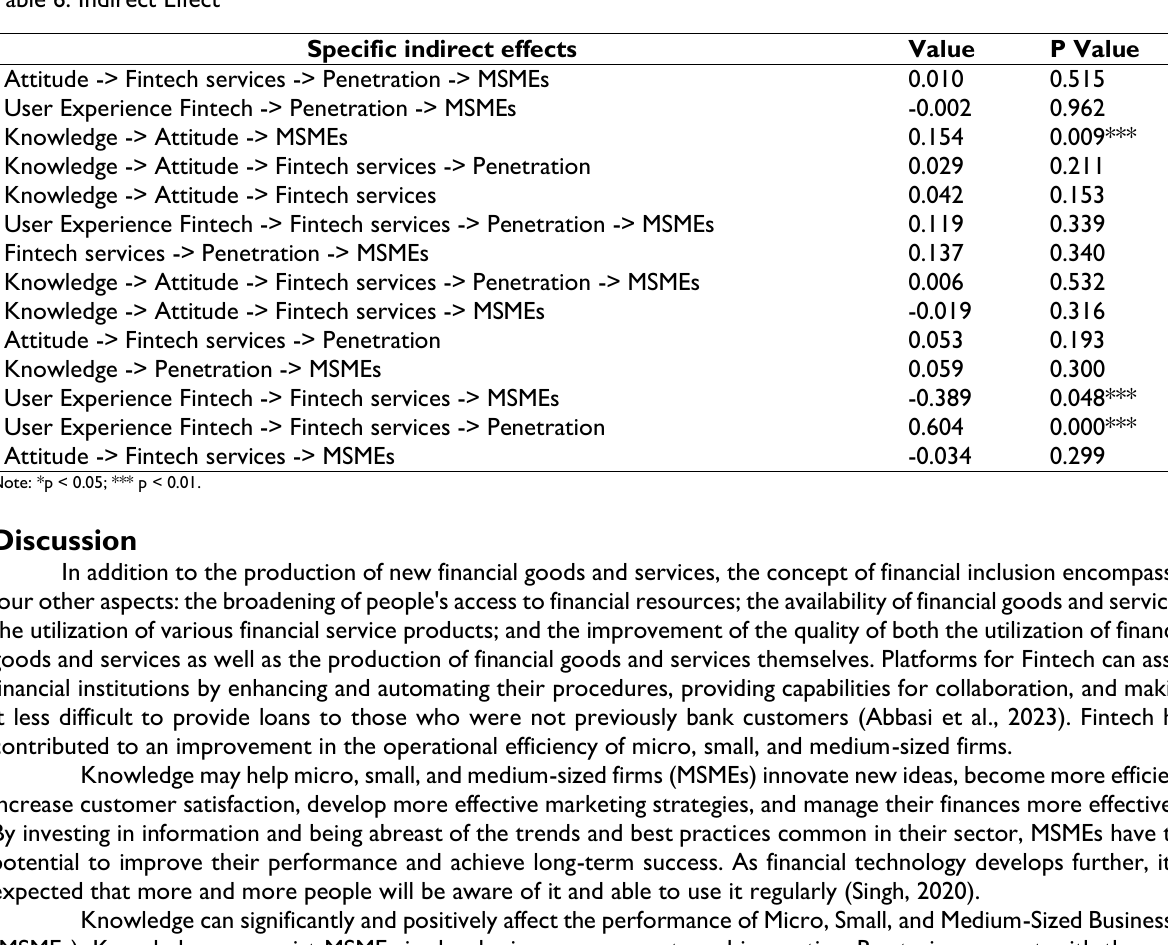
Table 6. Indirect